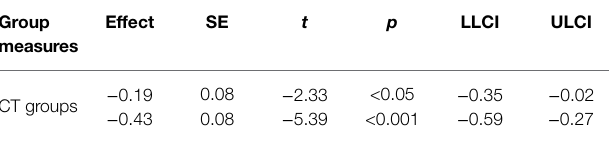
TABLE 3 | Conditional effect of X on Y at values of the